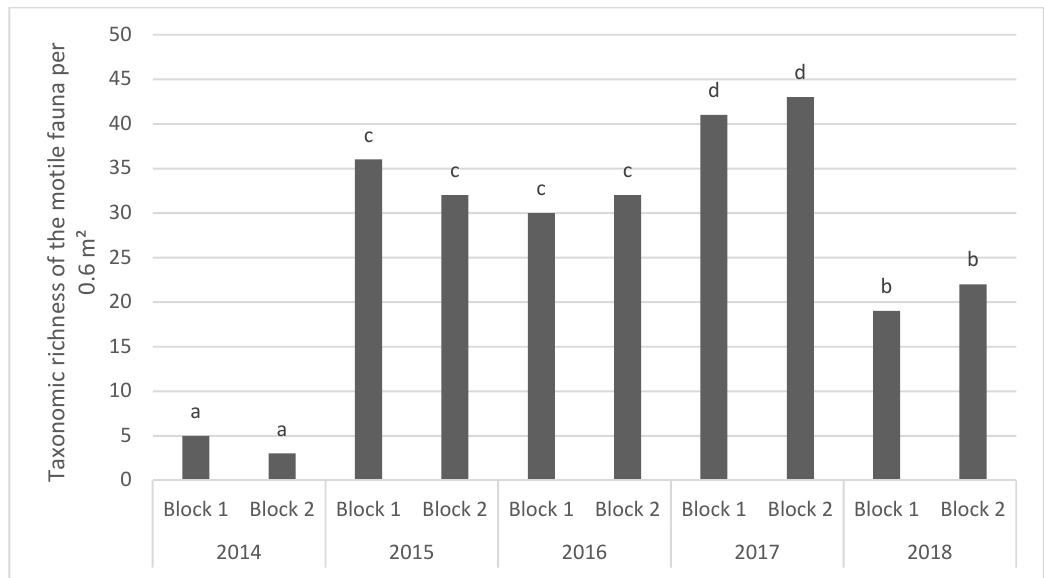
Figure 6. Taxonomic richness of the motile fauna per 0.6 m 2 in the ten blocks sampled from 2014 to 2018, with results of the Tukey tests (superscript: same letters in adjacent columns indicate no significant statistical difference between blocks and years).